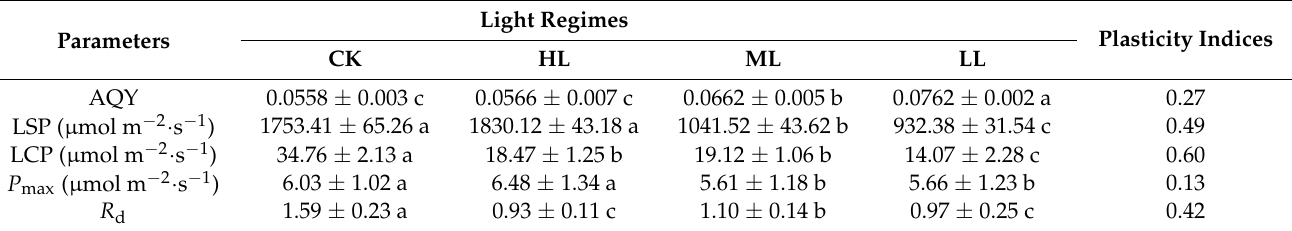
Figure 7. Photosynthetic curve parameters of C. oleifera leaves under different light regimes. Table 4. Photosynthetic parameters of C. oleifera leaves under different light regimes.